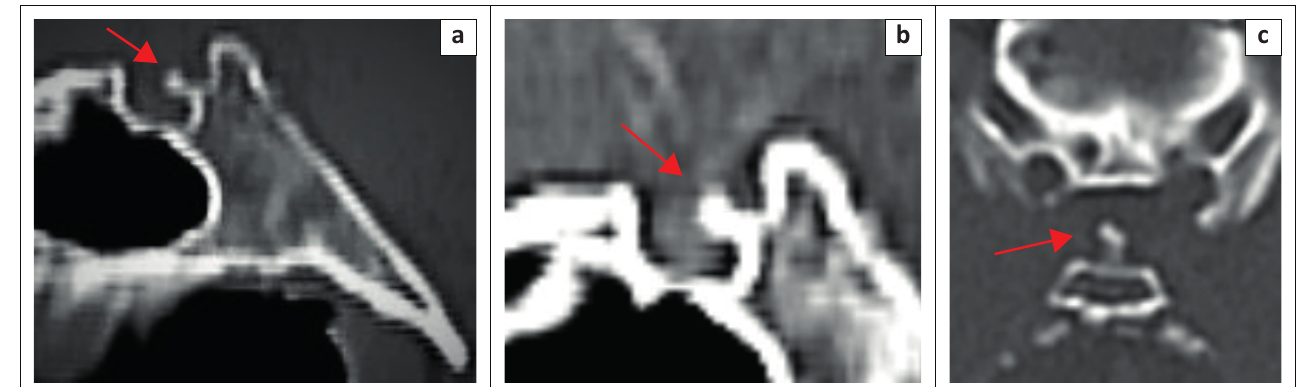
FIGURE 1: CT of the pituitary fossa. (a) Bone window in the sagittal plane in the midline demonstrating the sellar spine (arrow) protruding into the pituitary fossa producing a ‘figure of 3’ sign of the dorsum sellae. (b) Soft tissue window in the sagittal plane in the midline demonstrating compression of the pituitary and distal pituitary stalk by the sellar spine (arrow). (c) Bone window in the axial plane demonstrating the midline position of the sellar spine (arrow).